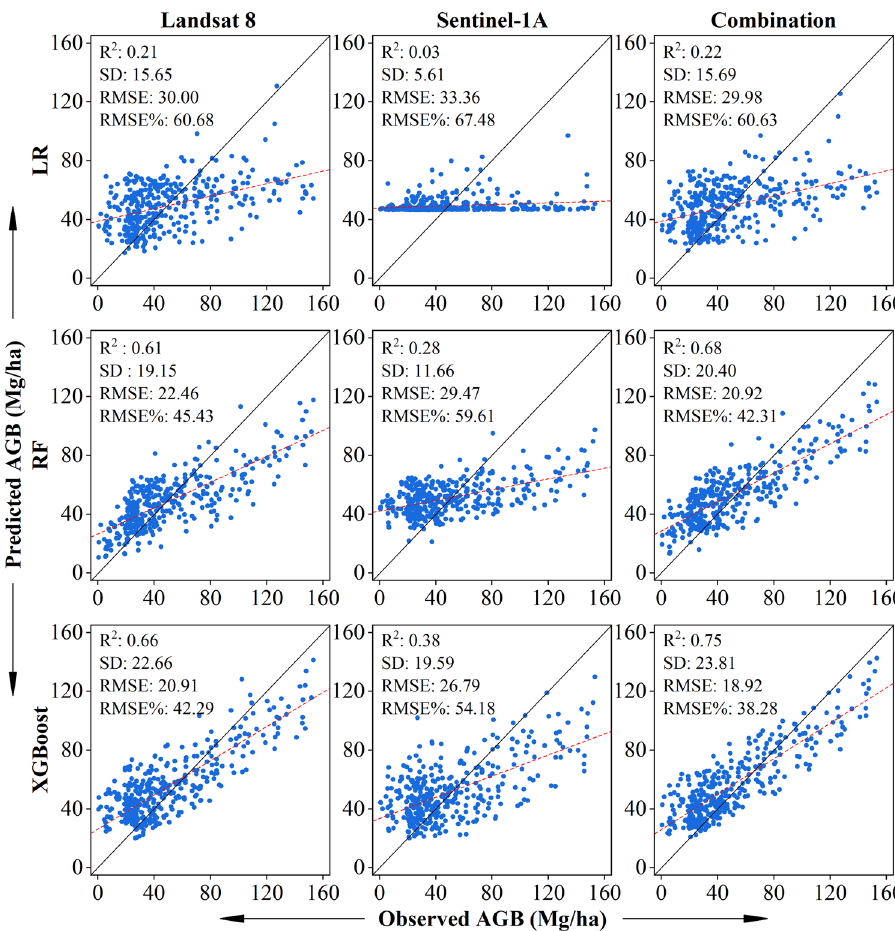
Figure 3. The predicted results of the LR, RF, and XGBoost models of the different